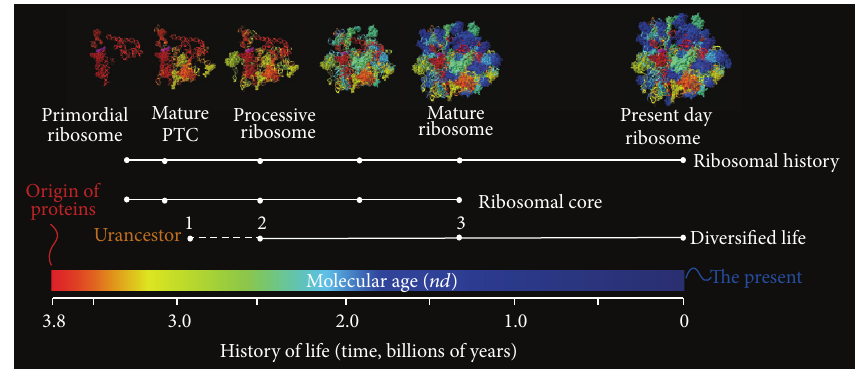
Figure 2: The evolutionary history of ribosome was traced onto the three-dimensional structure of its rRNA and r-protein components. Ages of components were colored with hues from red (ancient) to blue (recent). Phylogenomic history shows that primordial metabolic enzymes preceded RNA-protein interactions and the ribosome. The timeline of life derived from a universal phylogenetic tree of protein domain structure at fold superfamily level of complexity is shown with time flowing from left to right and expressed in billions of years according to a molecular clock of fold structures. The ribosomal timeline highlights major historical events of the molecular ensemble. History of the conserved ribosomal core [29] overlaps with that of diversified life [48], suggesting that episodes of cooption and lateral transfer have pervaded early ribosomal